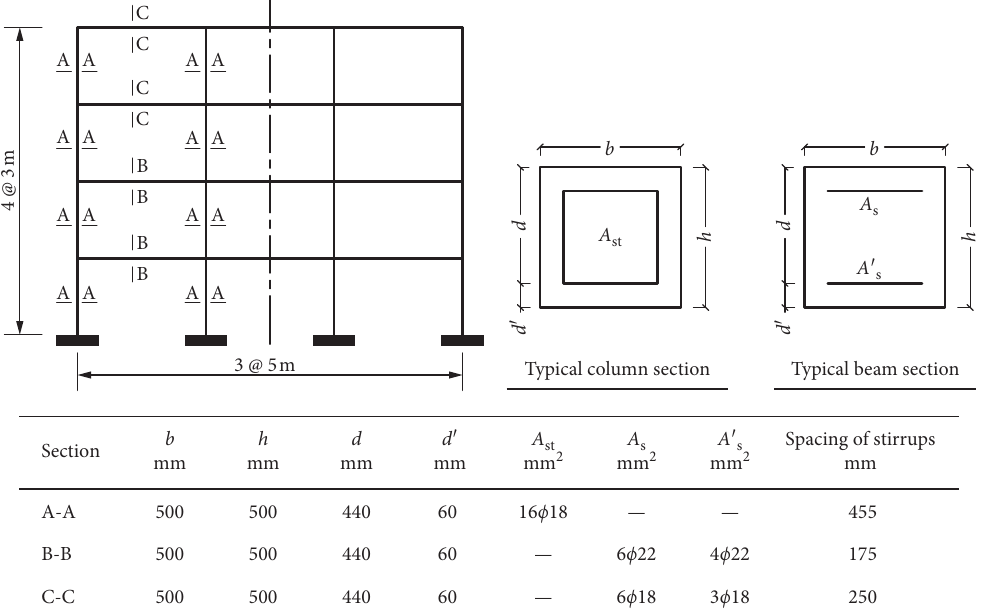
Figure 2: Four-storey frame.